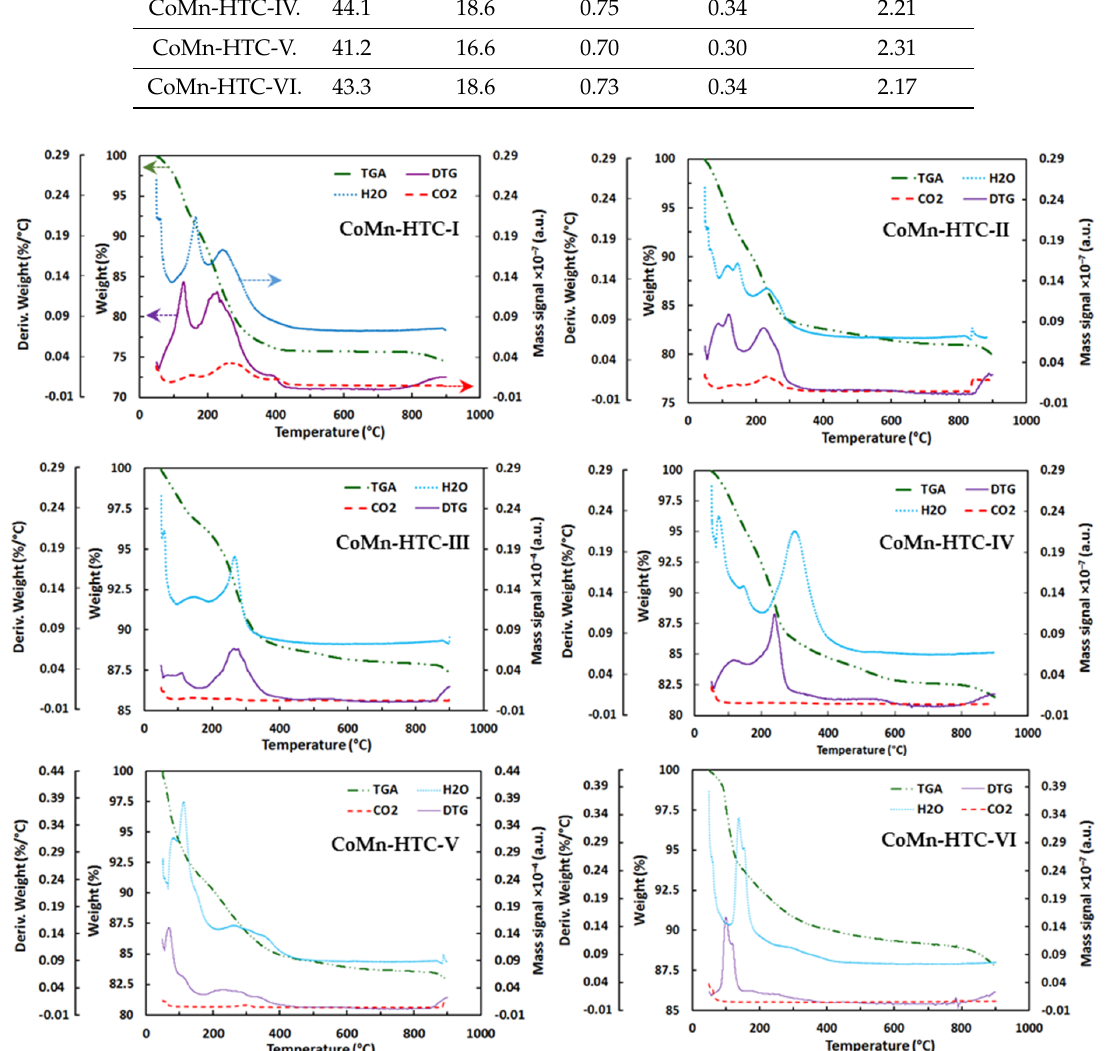
Figure 2. Thermogravimetric analysis and mass spectrometry detector (TGA-MS) analysis of the CoMn-HTC catalysts.